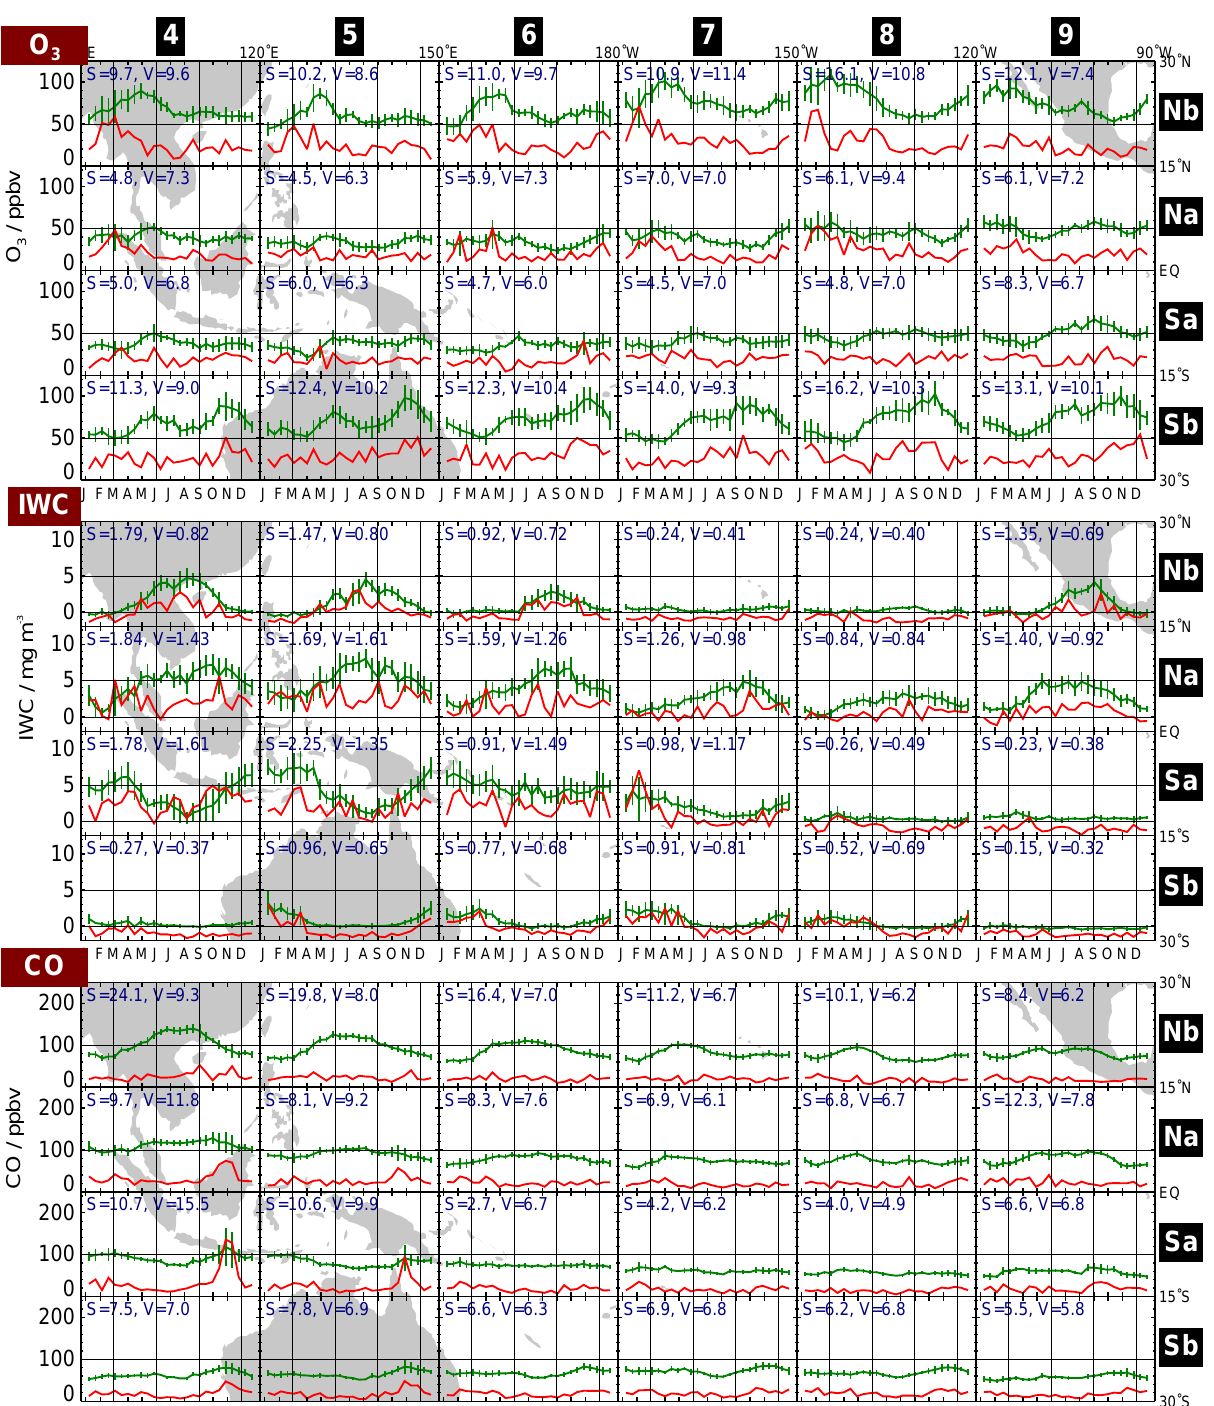
Fig. 4. As for Fig. 3 but for 90 ◦ E to 90 ◦